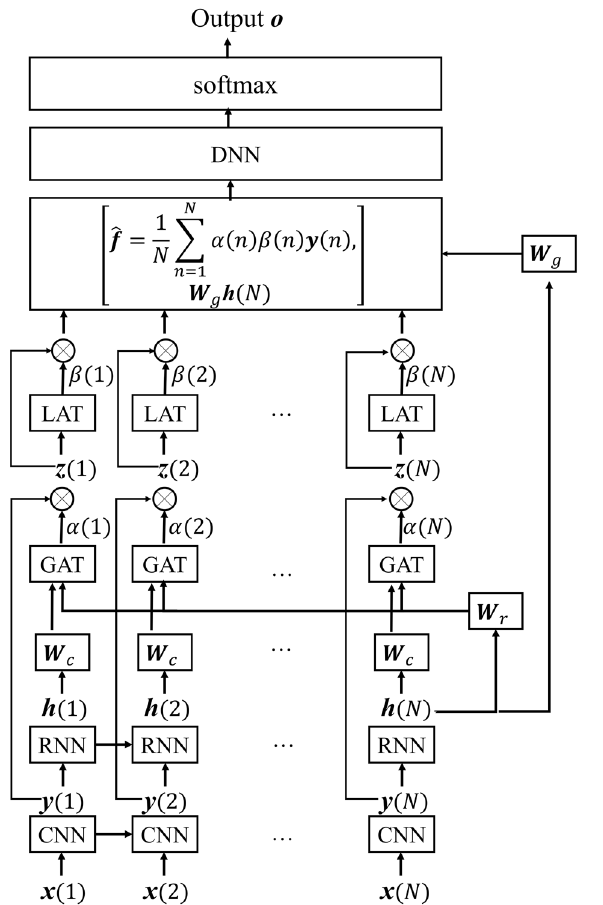
Figure 4. The mechanism of